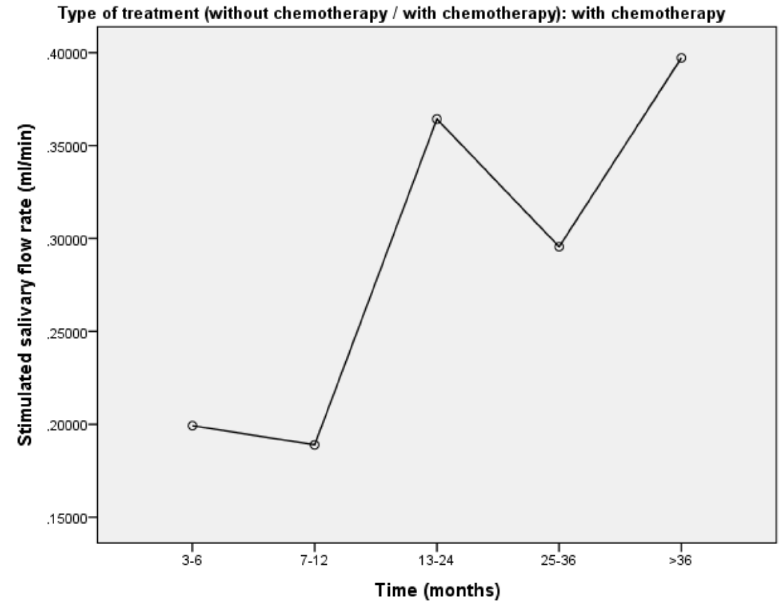
Figure 3- Mean stimulated salivary flow according to time in patients treated with radiotherapy plus